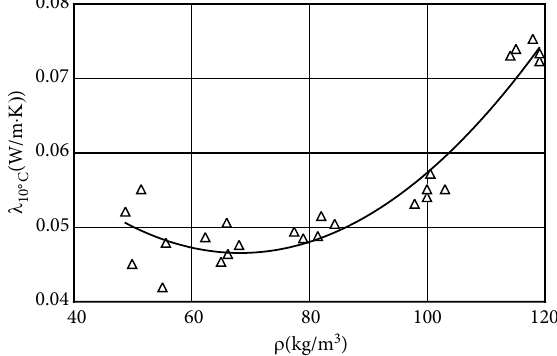
Fig. 5. The dependence of thermal conductivity on the density of horizontally oriented straw